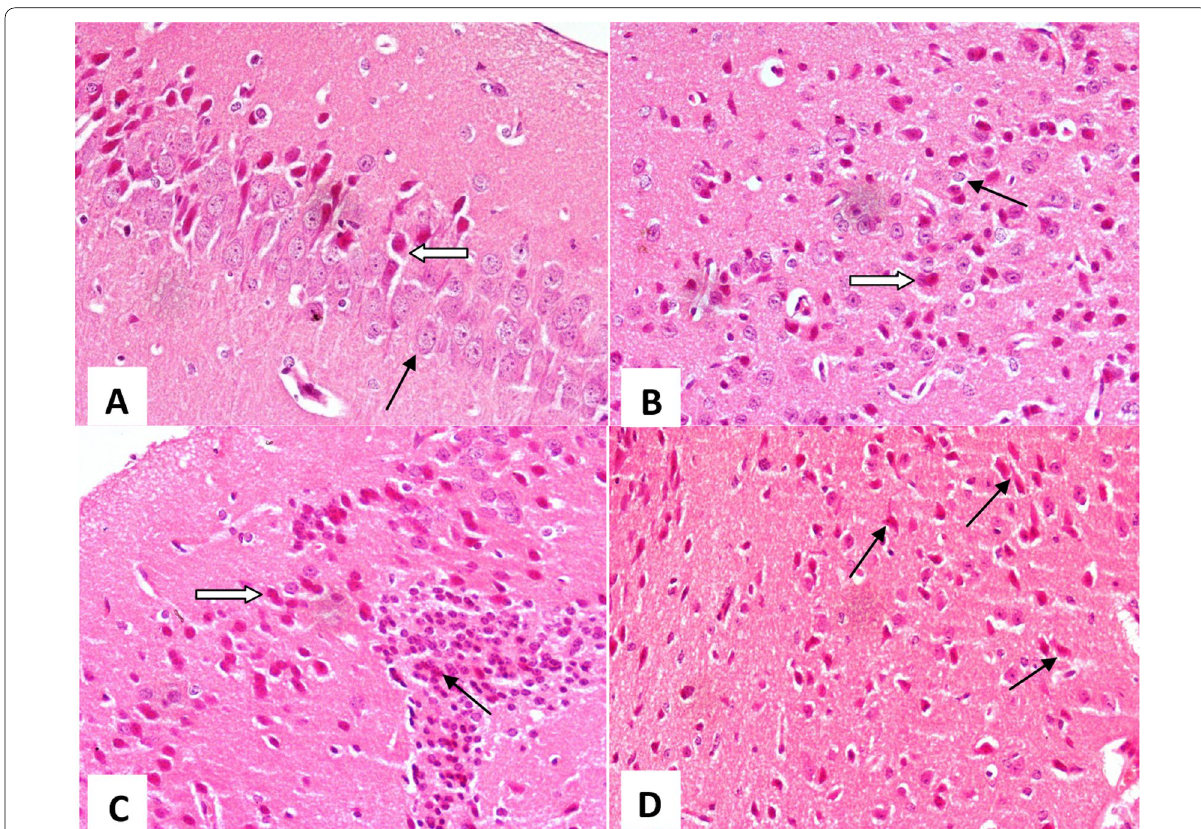
Fig. 9 A Brain tissue of mice treated with (R pyramidal neuronal cells (white arrow). B Brain tissue of mice treated with (R pigmented neuronal cells (white arrow) intermixed with several oligodendroglial cells (black arrow). C Cerebellar tissue of mice treated with (R CAF PQ) showing organized, cellular, granular cell layer (black arrow) with adjacent numerous pigmented pyramidal neuronal cells (white + + arrow). D Brain tissue of mice treated with (R